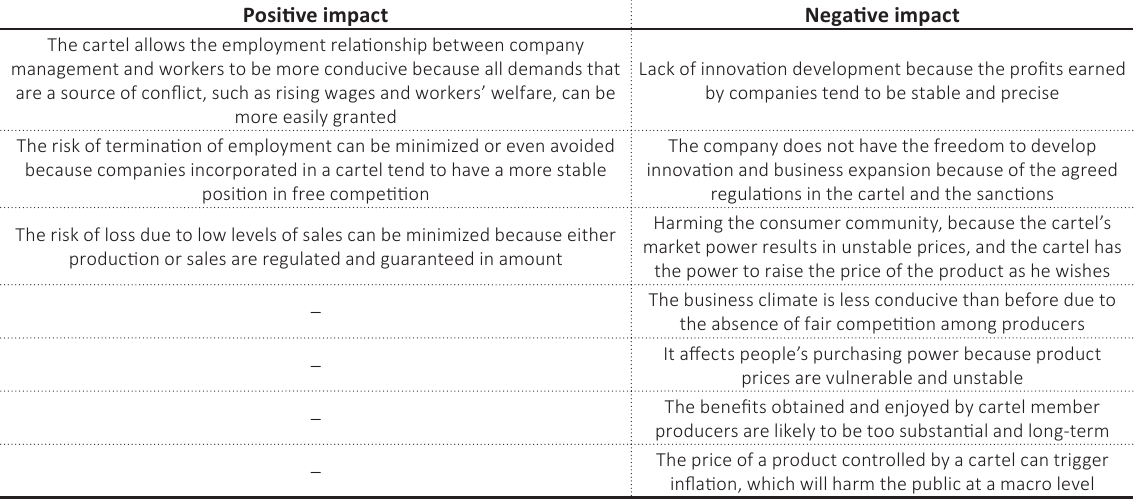
Table 1. Business cartel impact Positive impact Negative